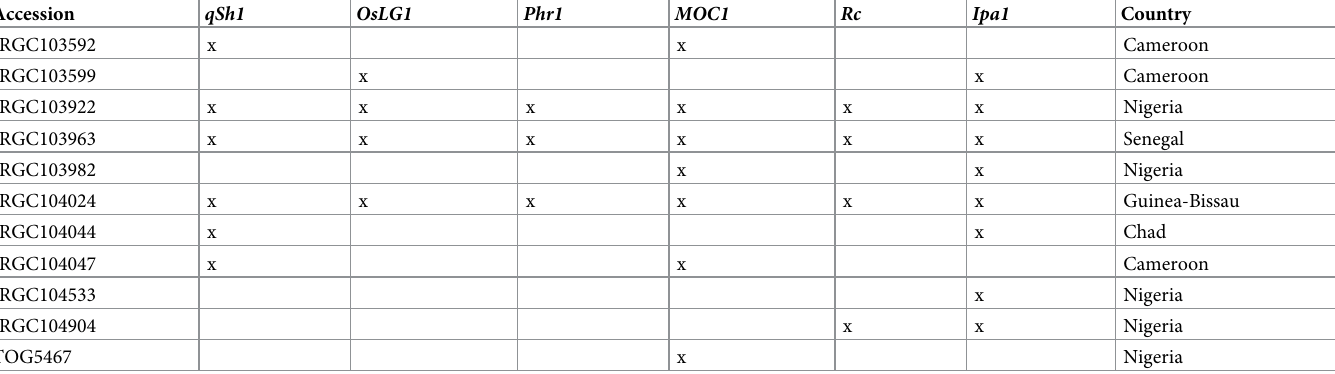
Table 4. OG-IV accessions possessing a different haplotype than the main O . glaberrima clade in multiple domestication genes. All these accessions have in common that they cluster with O . barthii accessions of similar ancestry and share a single haplotype with other O . glaberrima individuals for the genes that are marked with an